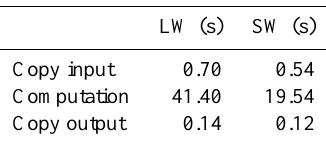
Table 7. Comparison of the computation time on the GPU versus the time needed to transfer the data to/from main memory and the GPU’s local